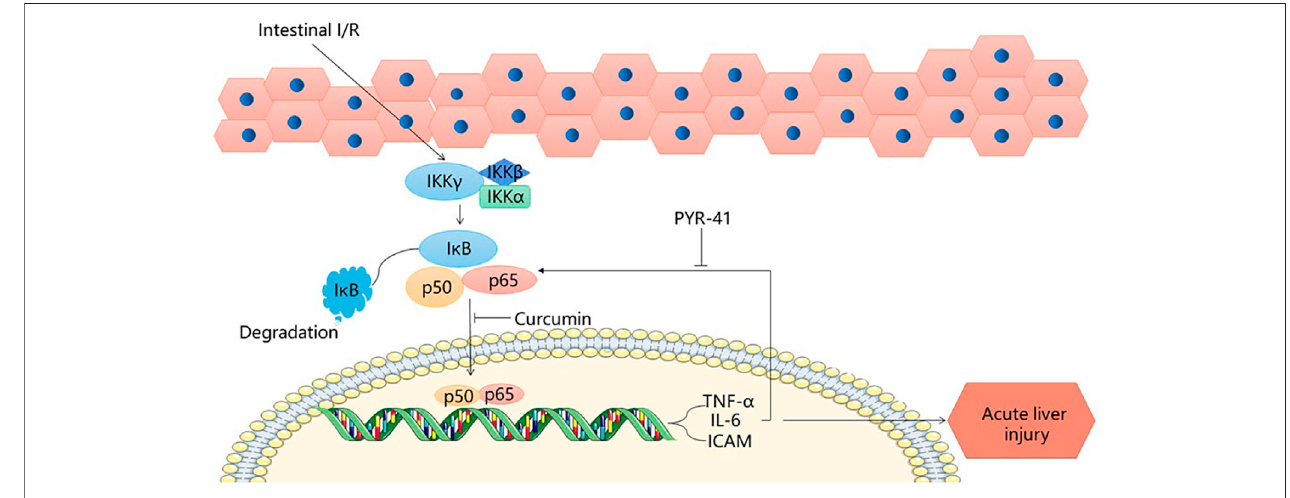
FIGURE 1 | NF- κ B signaling